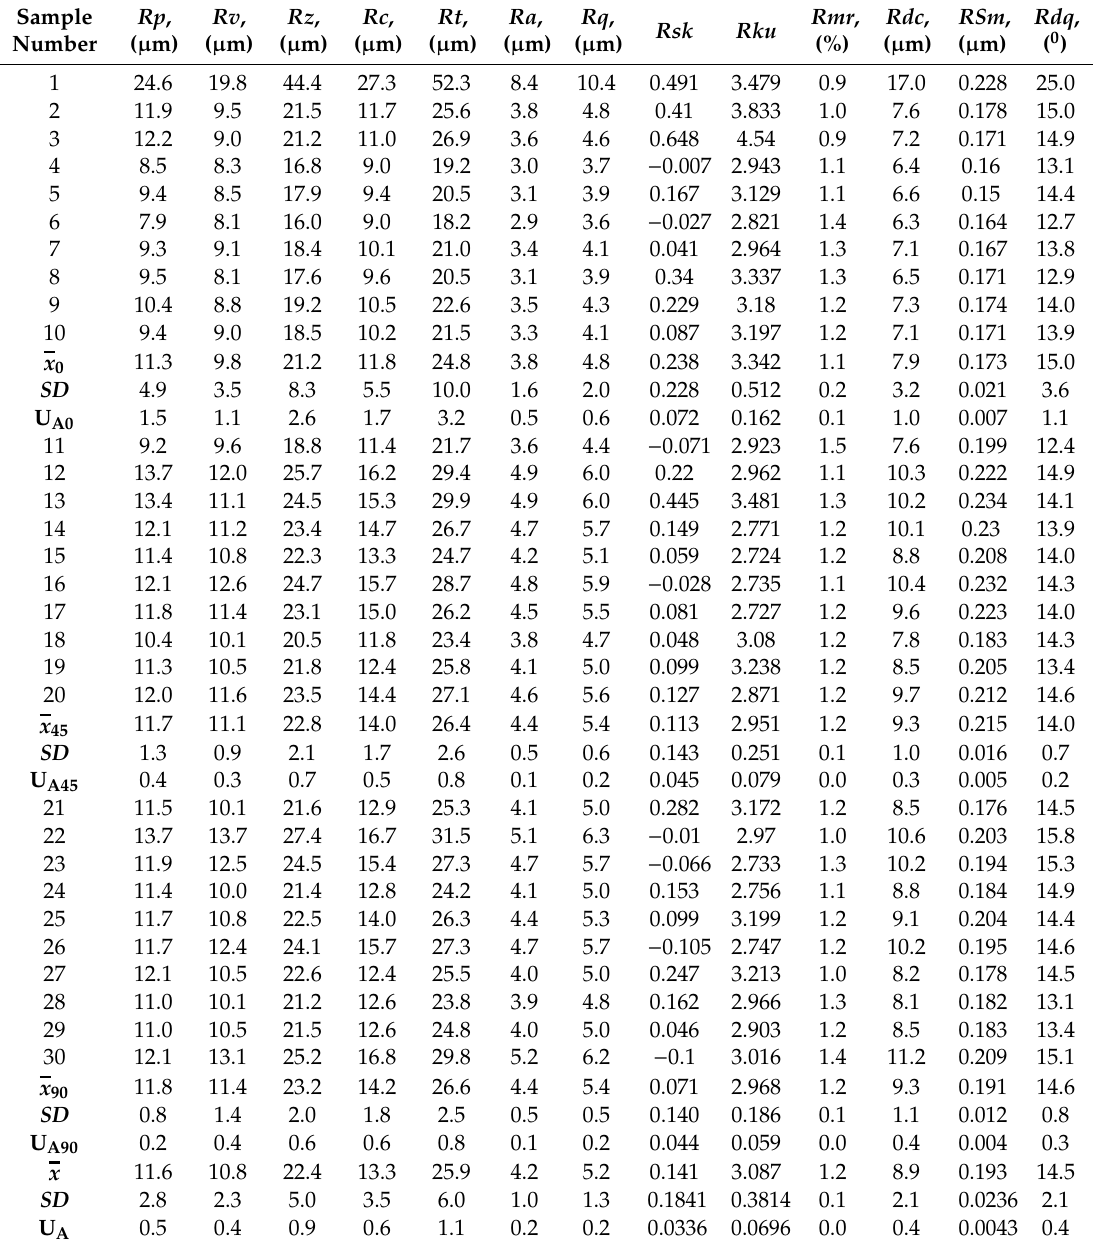
Table 3. Value of the 2D surface roughness